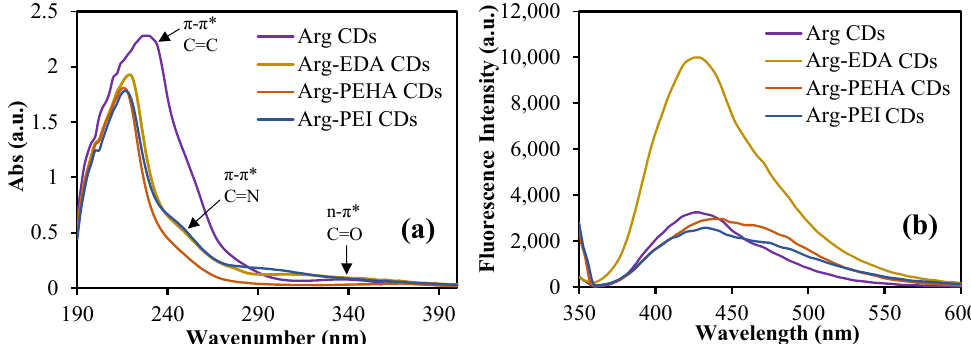
Figure 3. ( a ) UV–vis absorption spectra and ( b ) fluorescence emission spectra of amino-acid-derived CDs (excitation at 345 nm).